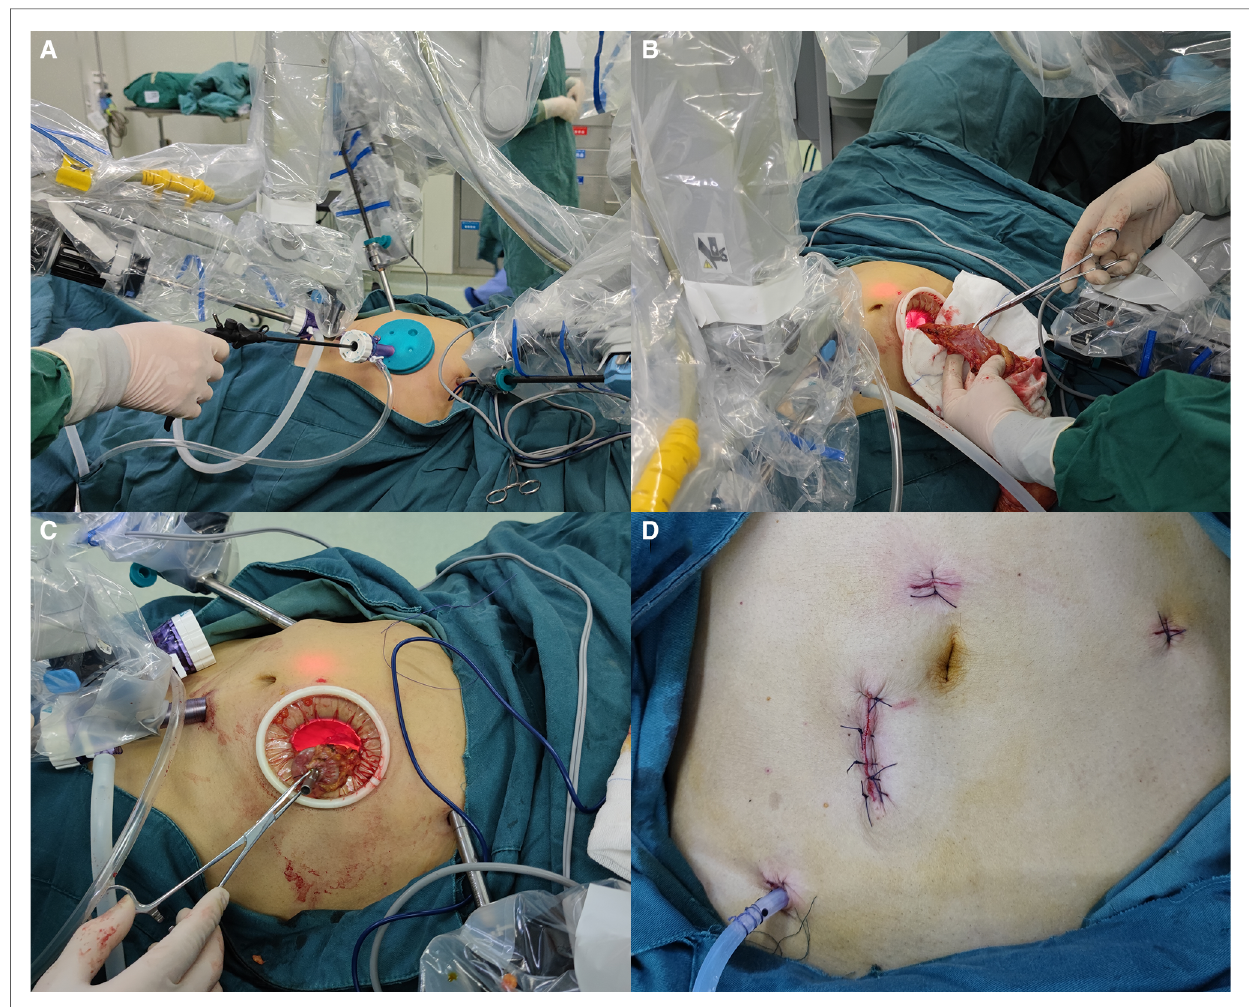
FIGURE 3 ( A ) The assistant assists in robotic surgery through the advance incision. ( B ) Removal of the specimen through the advance incision. ( C ) Embedding the tubular stapler anvil and replacing the proximal colon into the abdomen through the advance incision. ( D ) The photograph of the advance incision, port incisions, and the surgical drain after